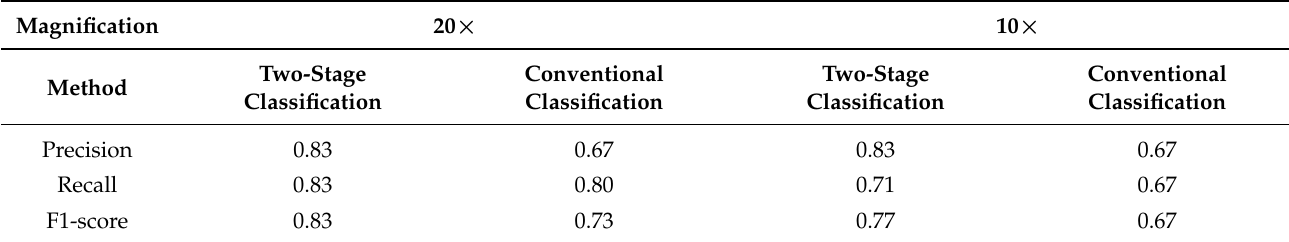
Figure 6. Patch-wise classification results of the MSI-H tissue, which were predicted as MSI-H for the proposed method but MSI-L for the conventional method. ( a ) The original WSI. The segmented tumor mask and the heatmap created using the proposed method and the conventional method with images at 20 × magnification( b – d ) and 10 × magnification( e – g ). Table 2. Performance of the proposed two-stage classification method compared to the conventional method on images at 20 × and 10 ×